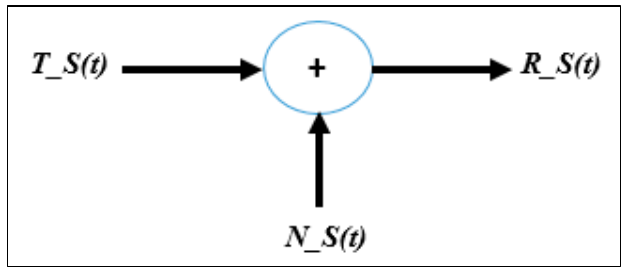
Figure 2. Basic signal model .